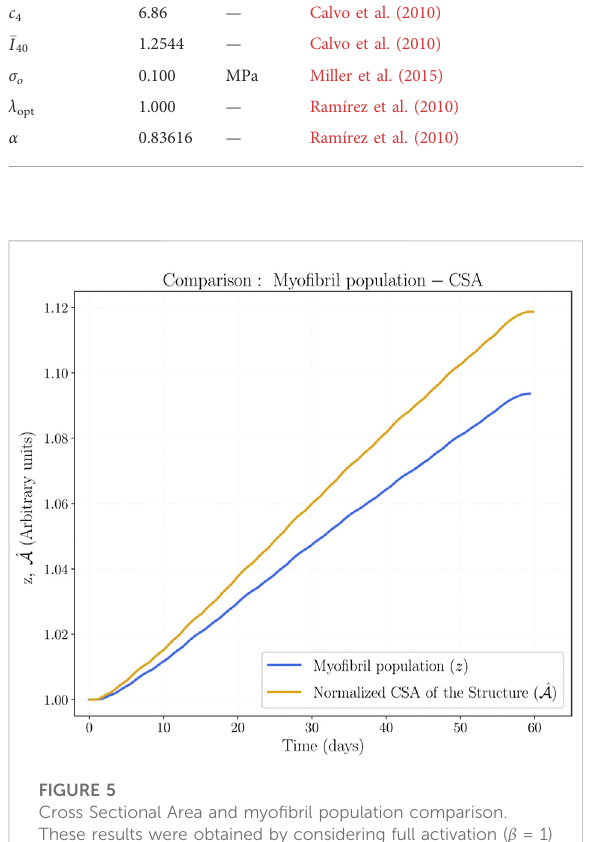
FIGURE 5 Cross Sectional Area and myo fi bril population comparison. These results were obtained by considering full activation ( β = 1) for the whole training protocol, and no feedback from the mechanical to the biochemical model.